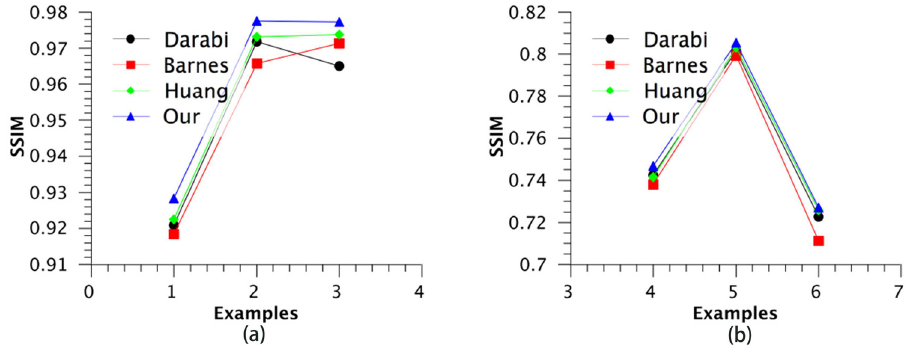
Fig 9. SSIM comprarison: (a) the results of the first three images in Fig 7 measured in SSIM, (b) the results of the last three images in Fig 7 measured in SSIM.